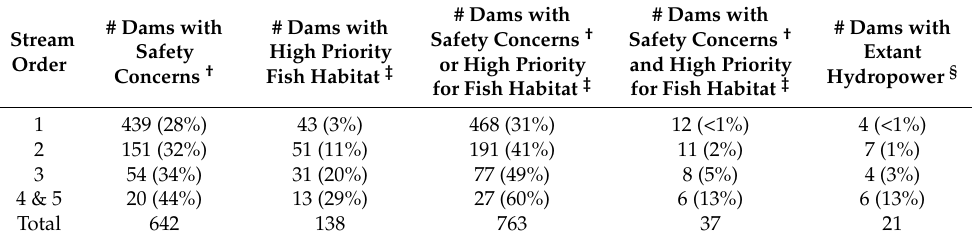
Table 4. Number (%) of N removal dams within different tradeoff categories by stream order. Stream Order